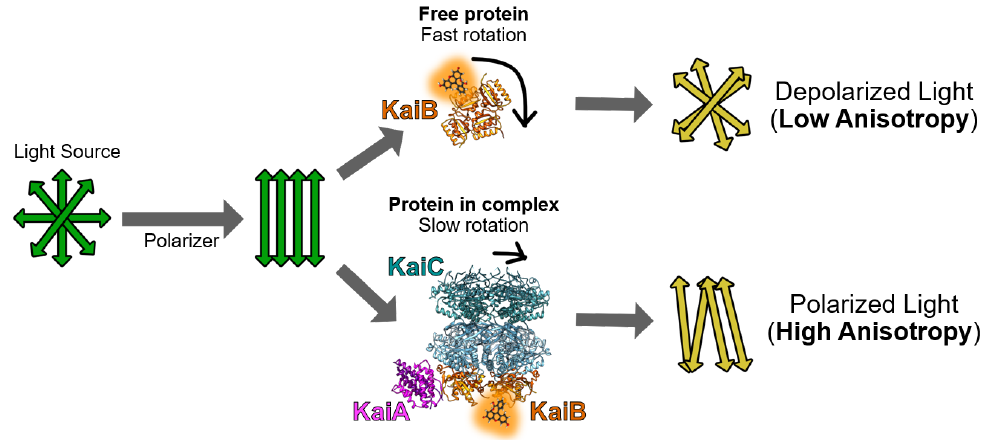
Figure 1. Cartoon of how labeled-KaiB protein free ( top ) and in ternary KaiA-KaiB-KaiC complexes ( bottom ) have significantly different fluorescence anisotropies. Rotational correlation times of the fluorophore can be extrapolated following a calibration of fluorescence anisotropy with neat fluorescein in the presence of glycerol, which has defined values [17].